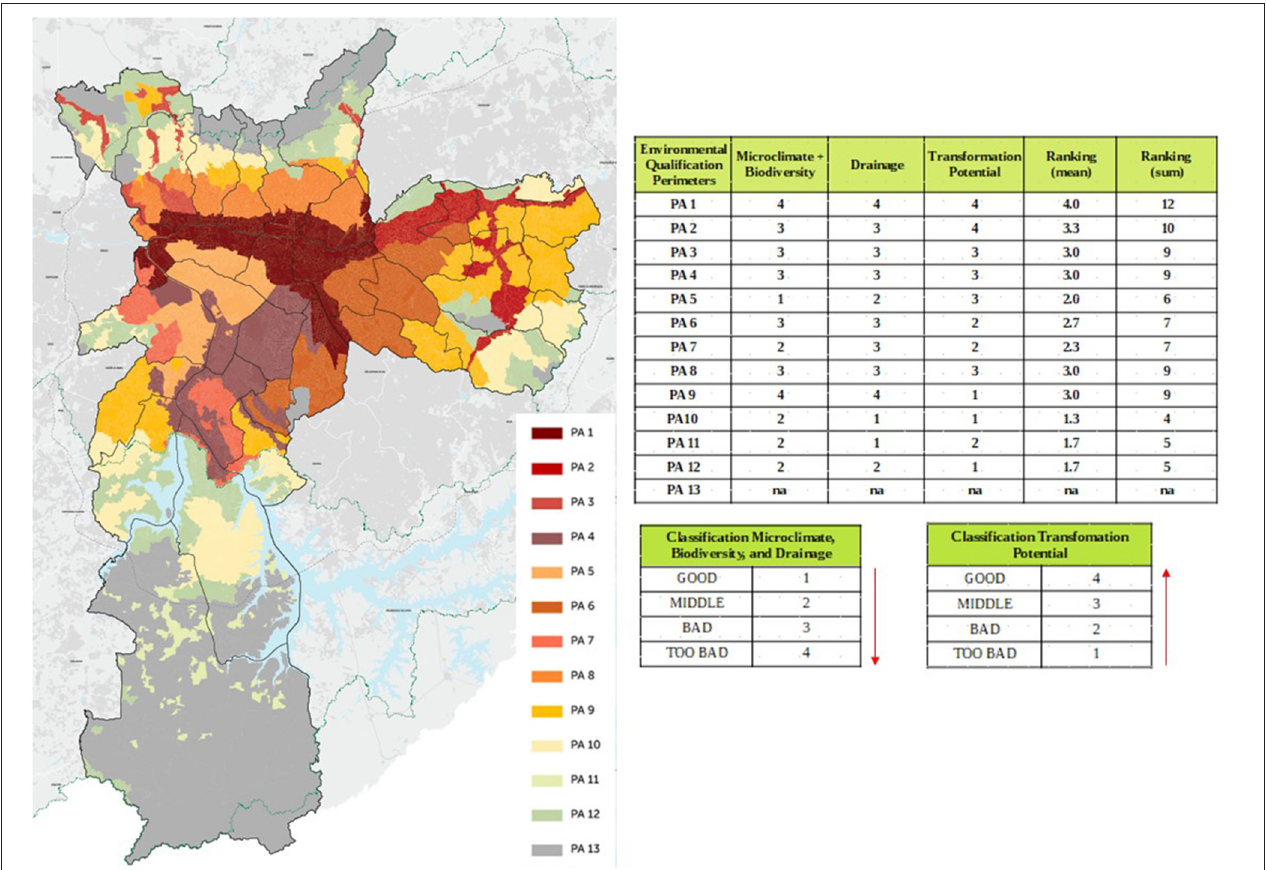
FIGURE 2 | Environmental Qualification Perimeters in the São Paulo municipality territory. Source: São Paulo City Hall; adapted by the authors. Environmental Qualification Perimeters (EQPs) are, in practice, environmental zoning. The territory of the municipality of São Paulo was divided into homogeneous regions into environmental terms, with 13 types of regions being defined. For each of the 13 types of EQPs, requirements are presented in the law in terms of minimum permeability (even for the lots dispensed from the EQ) as well as the minimum numerical values of the EQ score as a function of the lot size. To define EQPs’ degrees of rigor, each homogeneous region was evaluated in terms of indicators for (a) microclimate plus biodiversity, on a scale of 1–4, with 1 corresponding to the best state and 4 the worst; (b) drainage, idem; (c) transformation potential, on a scale of 1–4, with 4 corresponding to the best potential and 1 the worst. The indicators were then added together in order to be ranked. The higher the ranking, the greater the legal requirements of each EQP. The idea of including state indicators and a potential transformation indicator and providing them with values on an opposite scale rests on the following: an EQP with a good environmental state and very bad transformation potential receives the worst grades, having, therefore, the minor legal requirements in terms of EQ; on the contrary, an EQP with a deplorable environmental state and a good transformation potential receives the best grades, therefore having the highest legal requirements in terms of